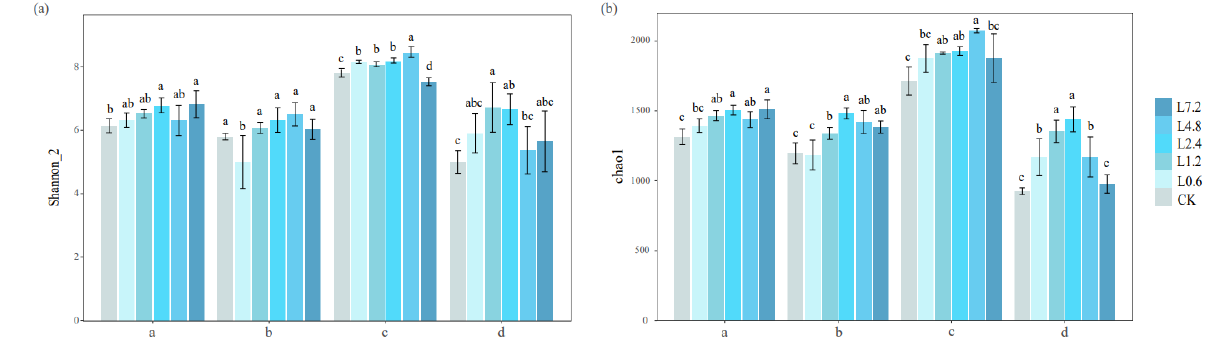
Figure 4. Effects of liming on soil bacterial alpha diversity indices Shannon_2 ( a ) and Chao1 ( b ). The lowercase letters under the abscissa represent soil types, different letters above each bar indicate significant differences ( p < 0.05) among different treatments of the same soil.